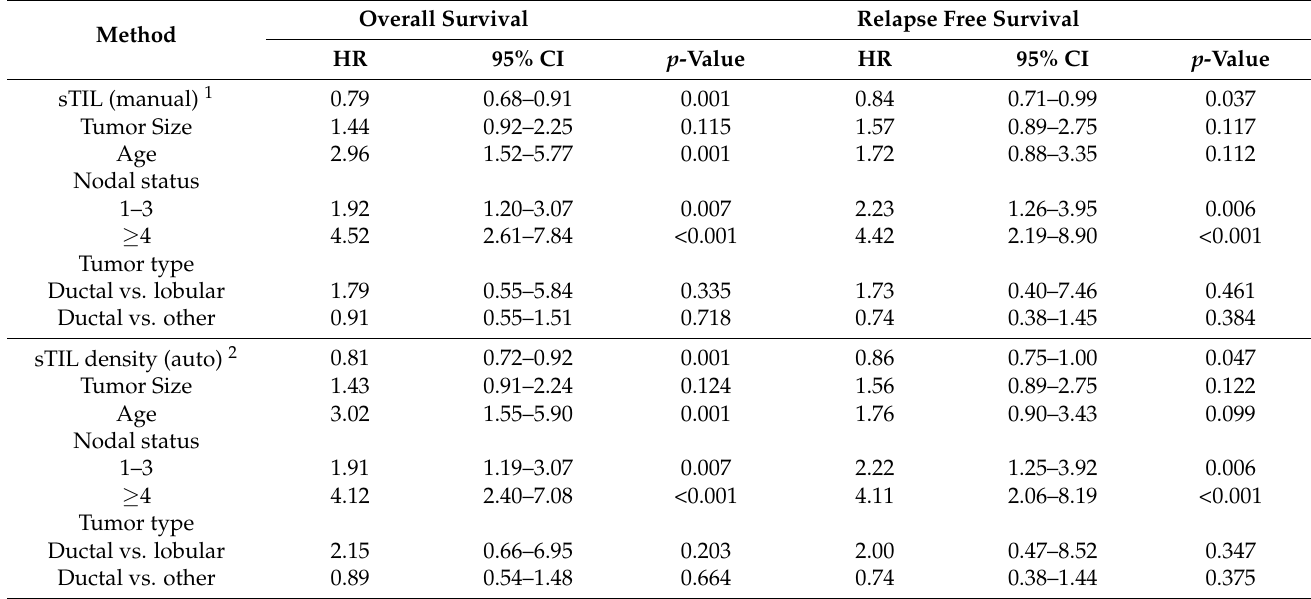
Table 2. Multivariate analysis: 1 Manual score is in increments of 10. 2 sTIL Density is continuous but normalized to increments of 300 sTILs/mm 2